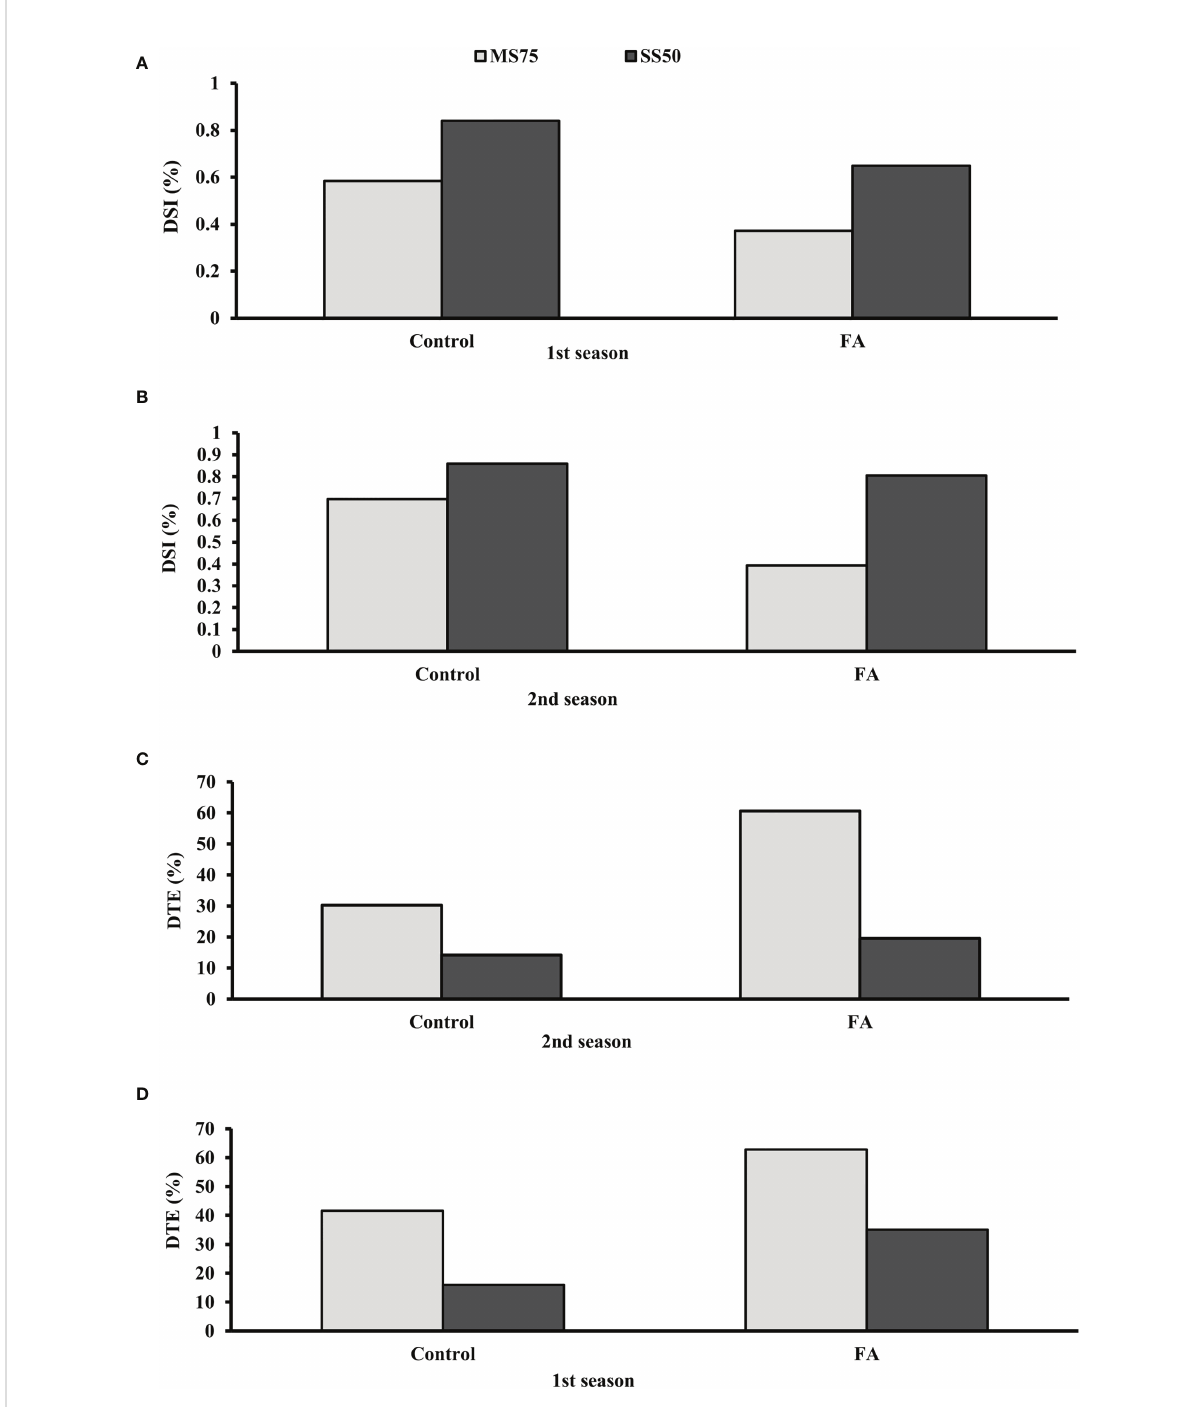
FIGURE 12 Effect of foliar application of folic acid (50 mM) on (A, B) drought susceptibility index and (C, D) drought tolerance ef fi ciency in the fi rst and second